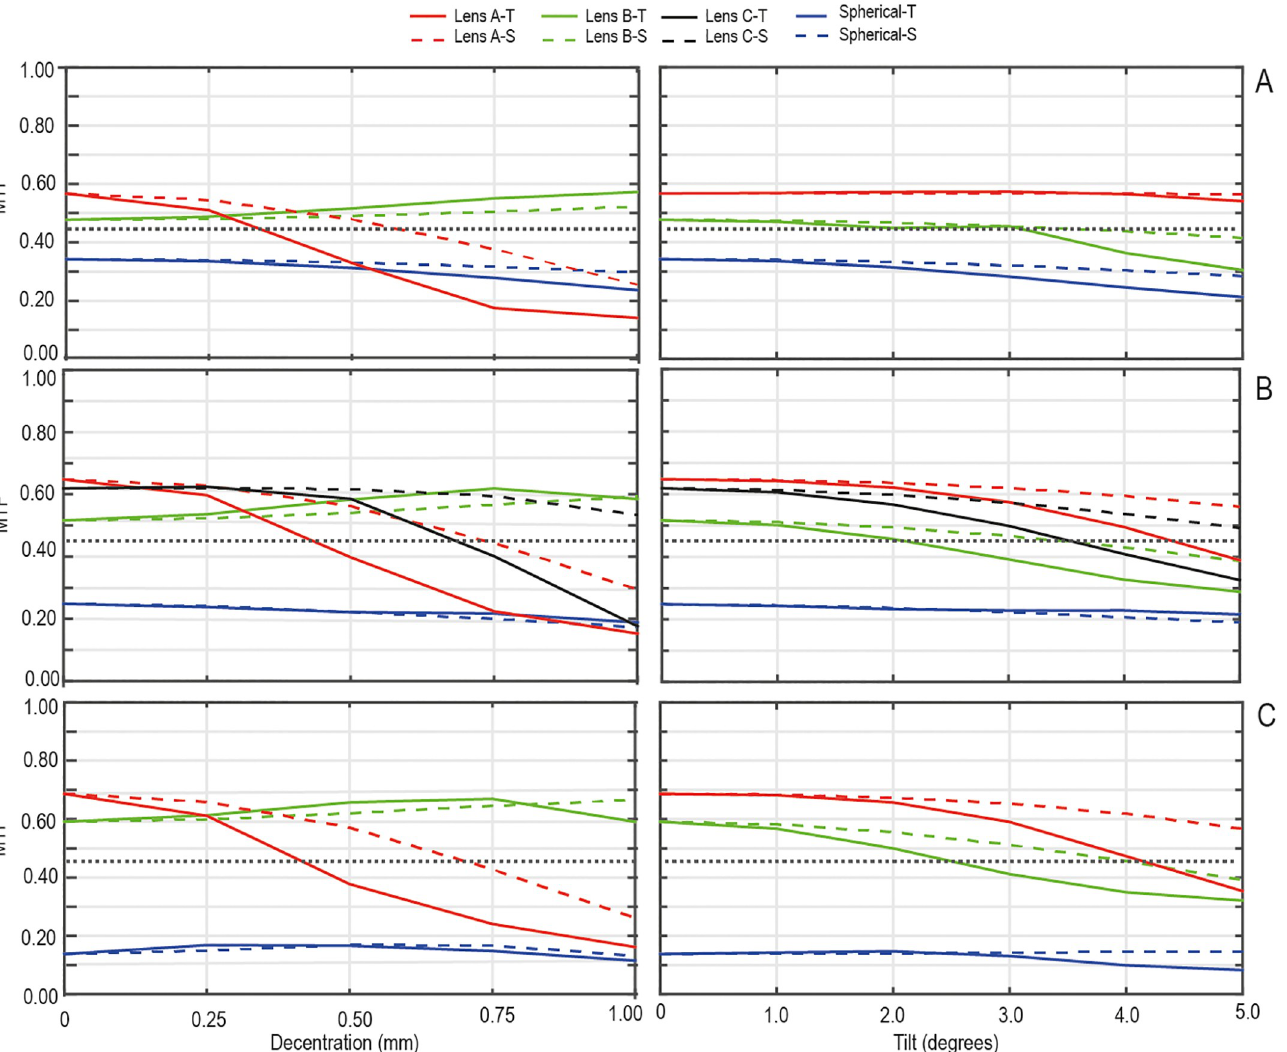
Fig 2. The MTF of the tested IOLs as a function of decentration (left column) and tilt (right column) with a 3.00 mm pupil diameter and 100 cycles per degree. The tangential MTF (continuous line) and the sagittal MTF (dashed line) are shown for each refractive power: A) +10.00 D, B) +20.00 D, and C) +35.00 D. The horizontal dashed line represents the value of MTF 0.43 specified in the ISO 11979–2 [23].